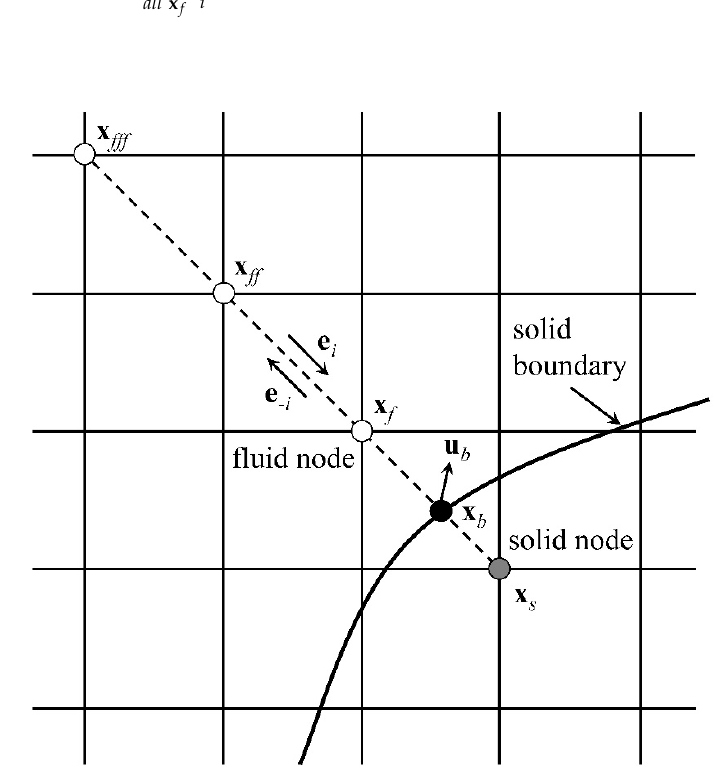
Figure 4. Schematic of the double interpolation scheme.